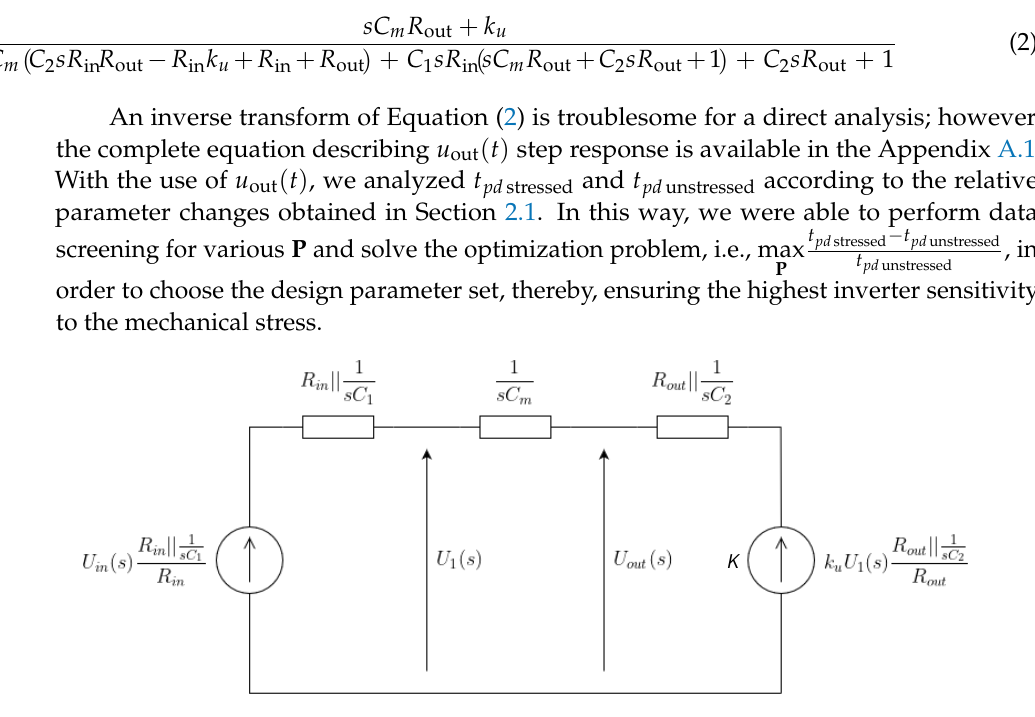
Figure 9. Linearized version of the